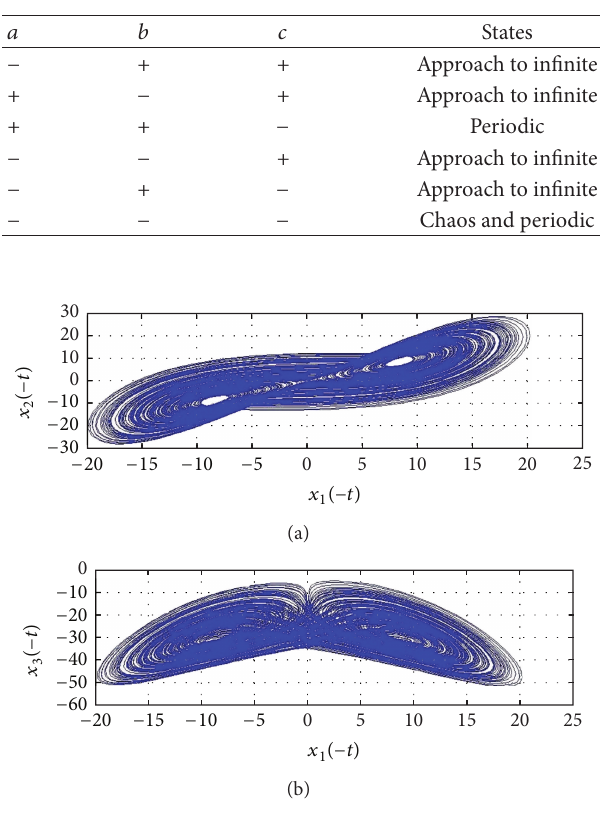
Figure 2: Projections of phase portrait of chaotic historical Lorenz system with 𝑌 in 𝑎 = −10 , 𝑏 = −8/3 , and 𝑐 = −28 .